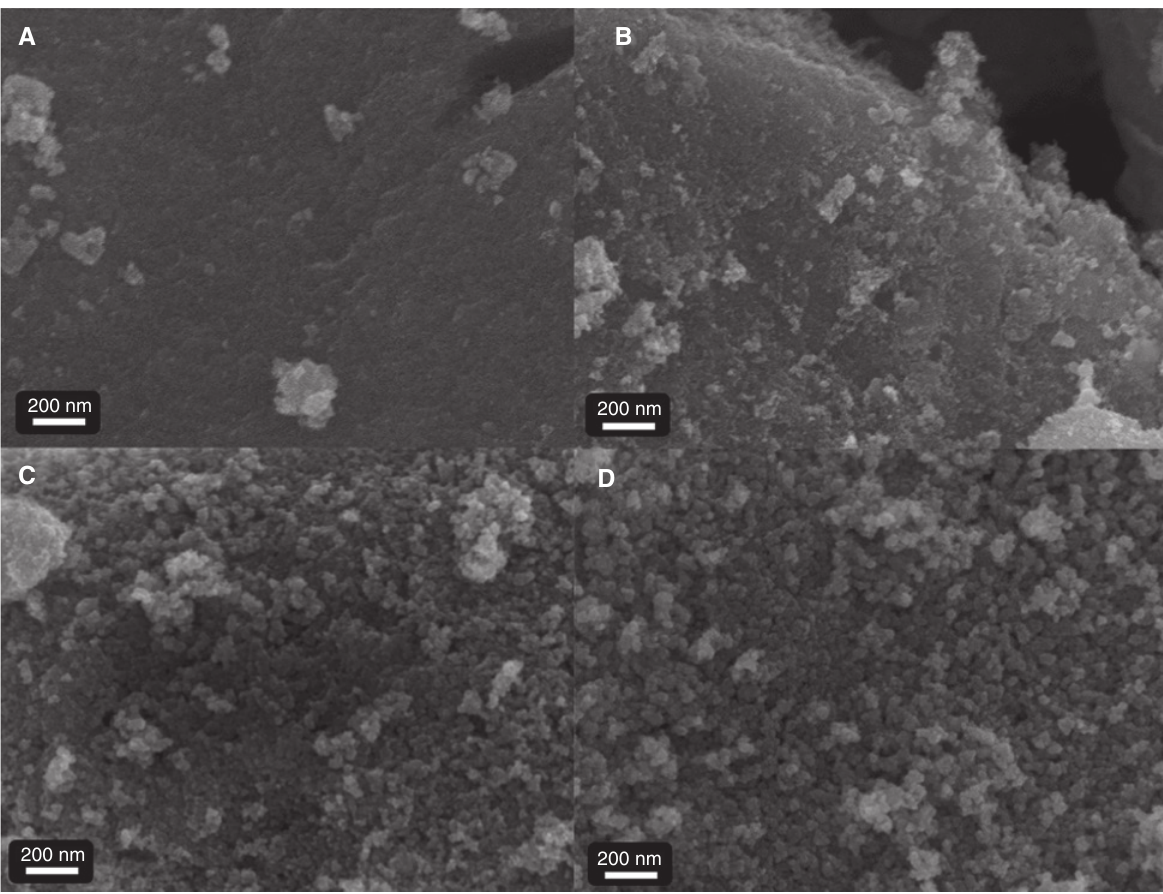
Figure 2: The FESEM images of the antimony-doped tin oxide (ATO) nanoparticles (NPs) (Sn/Sn + Sb = 10% at.) obtained with calcination temperatures: (A) as-synthesized, (B) 500 ° C, (C) 800 ° C, and (D) 1000 °